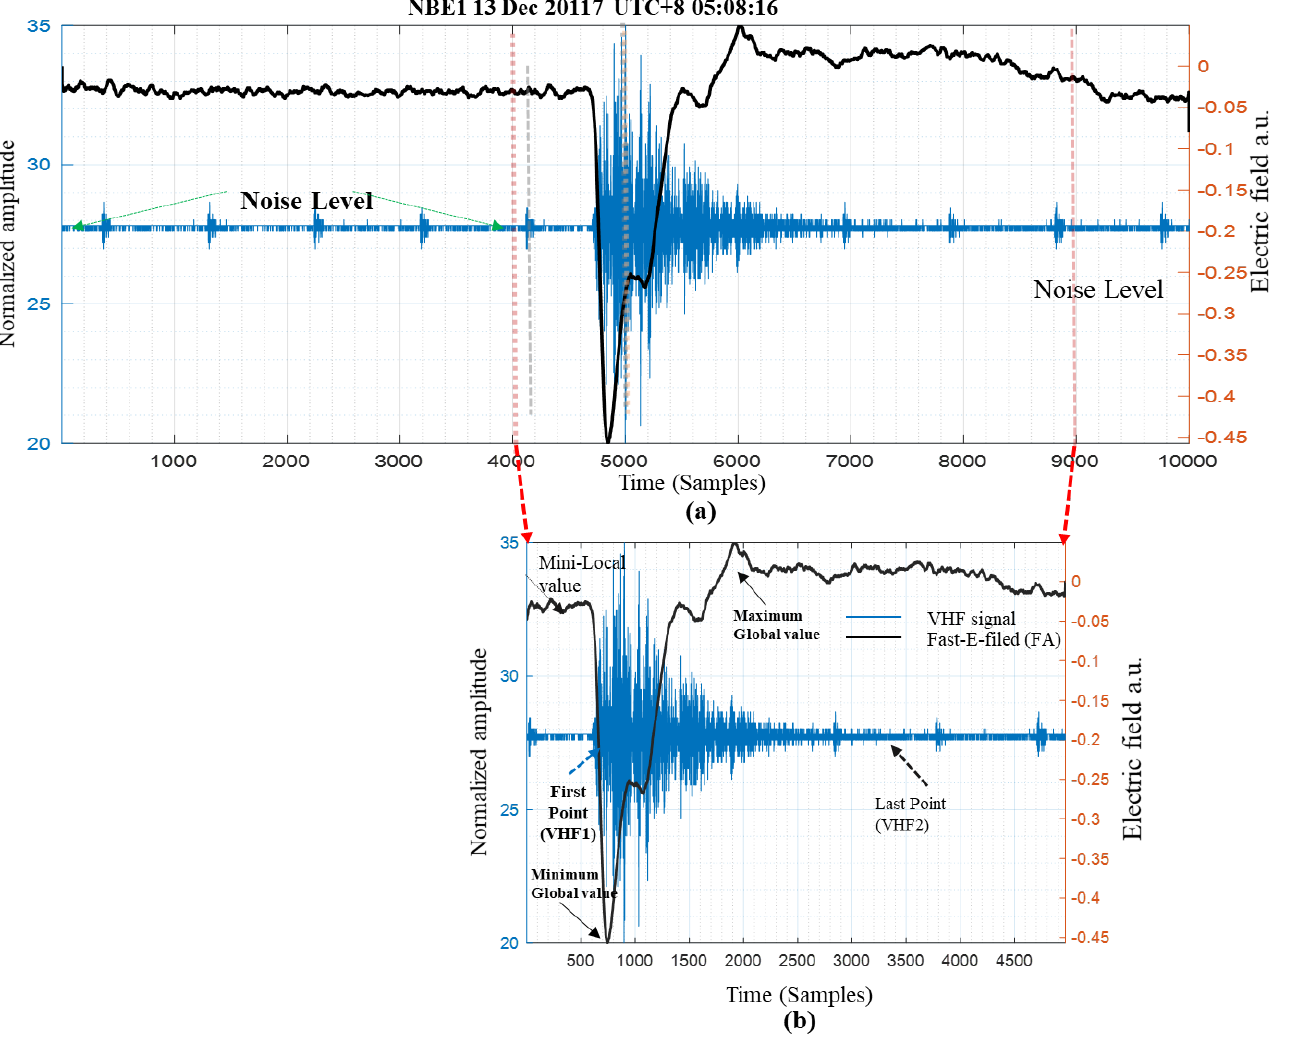
Figure 8. Interferometer data NBE1: ( a ) original ITF data; ( b ) lightning event extraction.